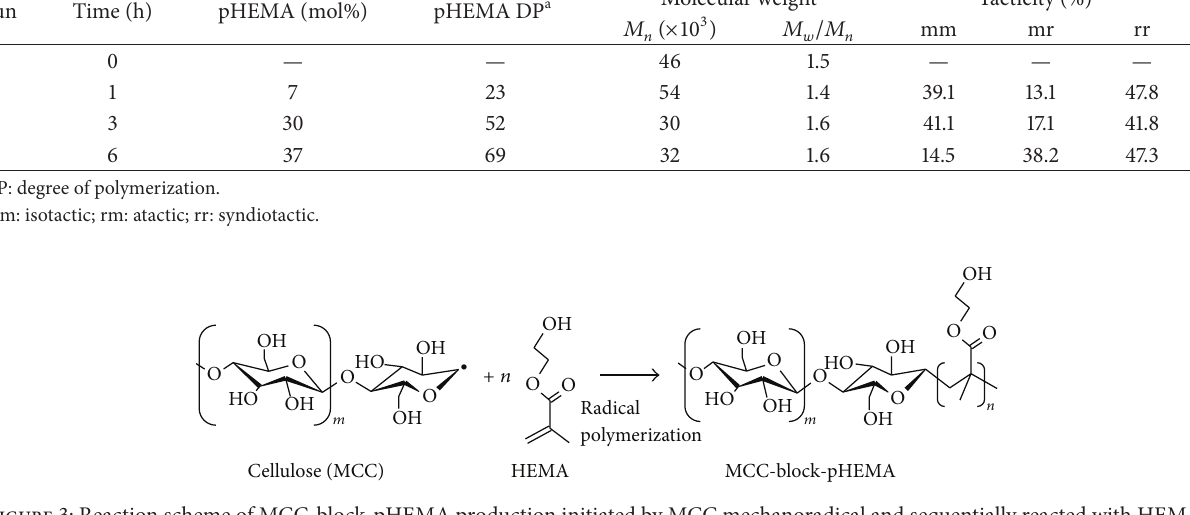
Figure 3: Reaction scheme of MCC-block-pHEMA production initiated by MCC mechanoradical and sequentially reacted with HEMA.